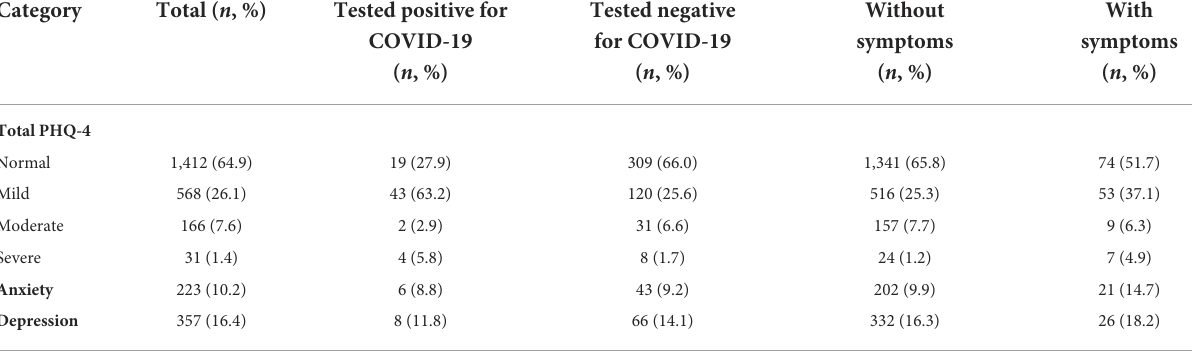
FIGURE1 Time needed for full recovery.